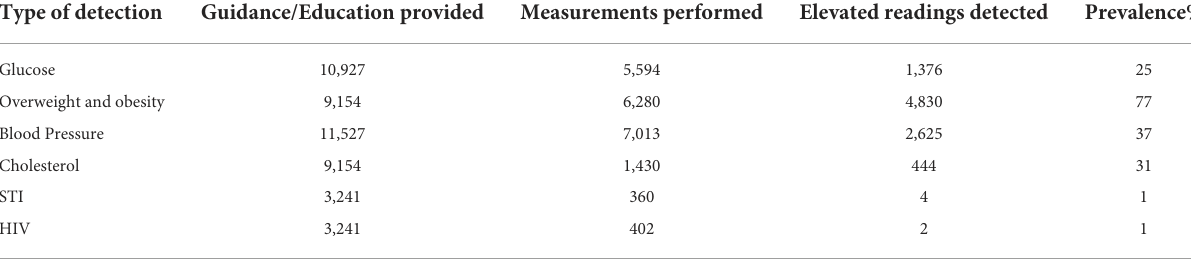
TABLE 3 Prevalence of the main health conditions treated at the VDS and MHU, January 2020–July